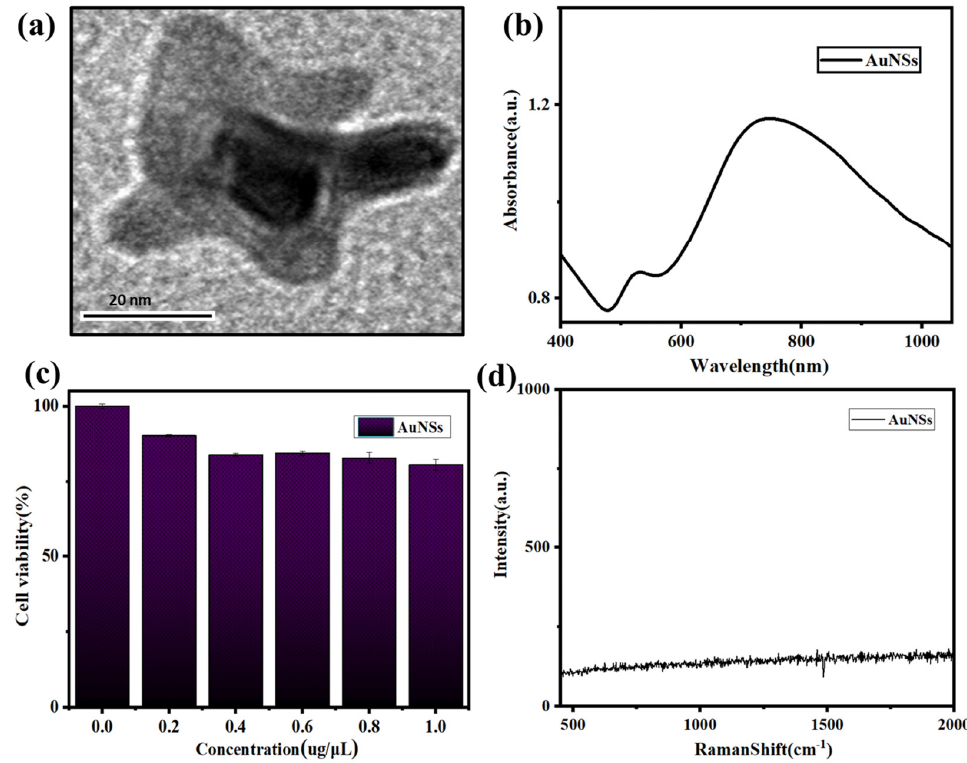
Figure 2. Characterization of the AuNSs. ( a ) Scanning electron microscope images of AuNSs. ( b ) UV-visible absorption spectrum of AuNSs. ( c ) Cytotoxicity test of AuNSs. ( d ) Raman signal of AuNSs.